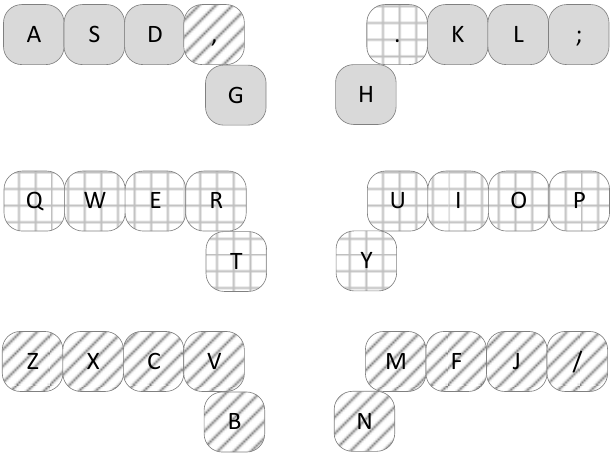
Figure 5. A-VX-ORK+